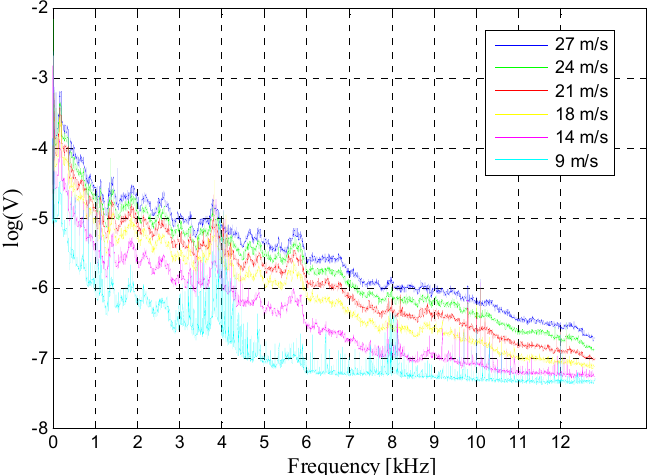
Figure 13. Curve of output with frequency at different wind speeds.